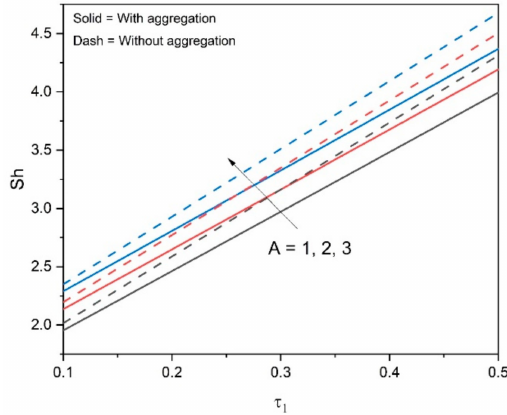
Figure 12. Influence of Sh on τ 1 for numerous values of A